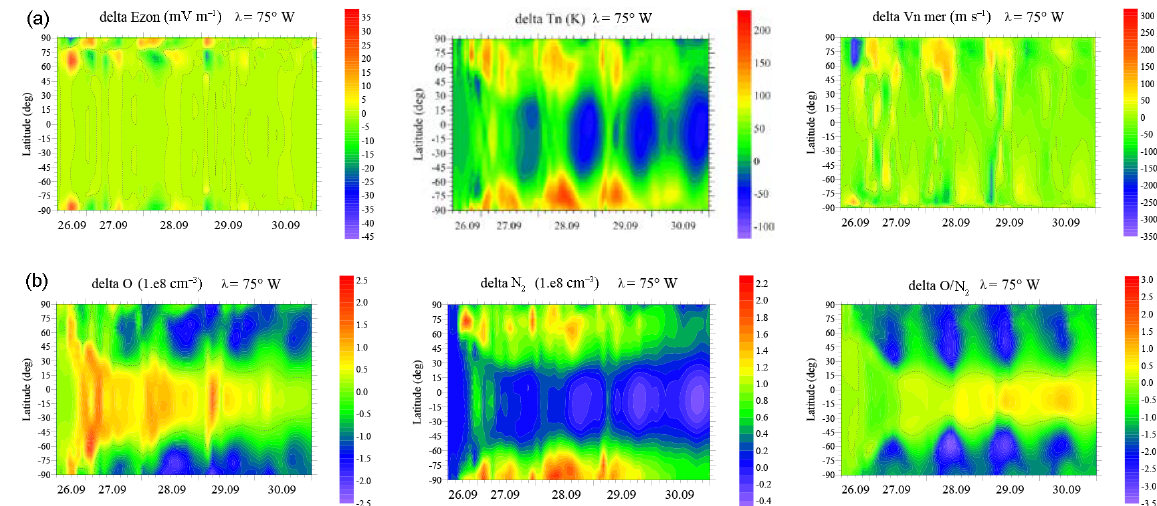
Figure 7. The same as in Fig. 5, but for the longitude of 75 ◦ W.